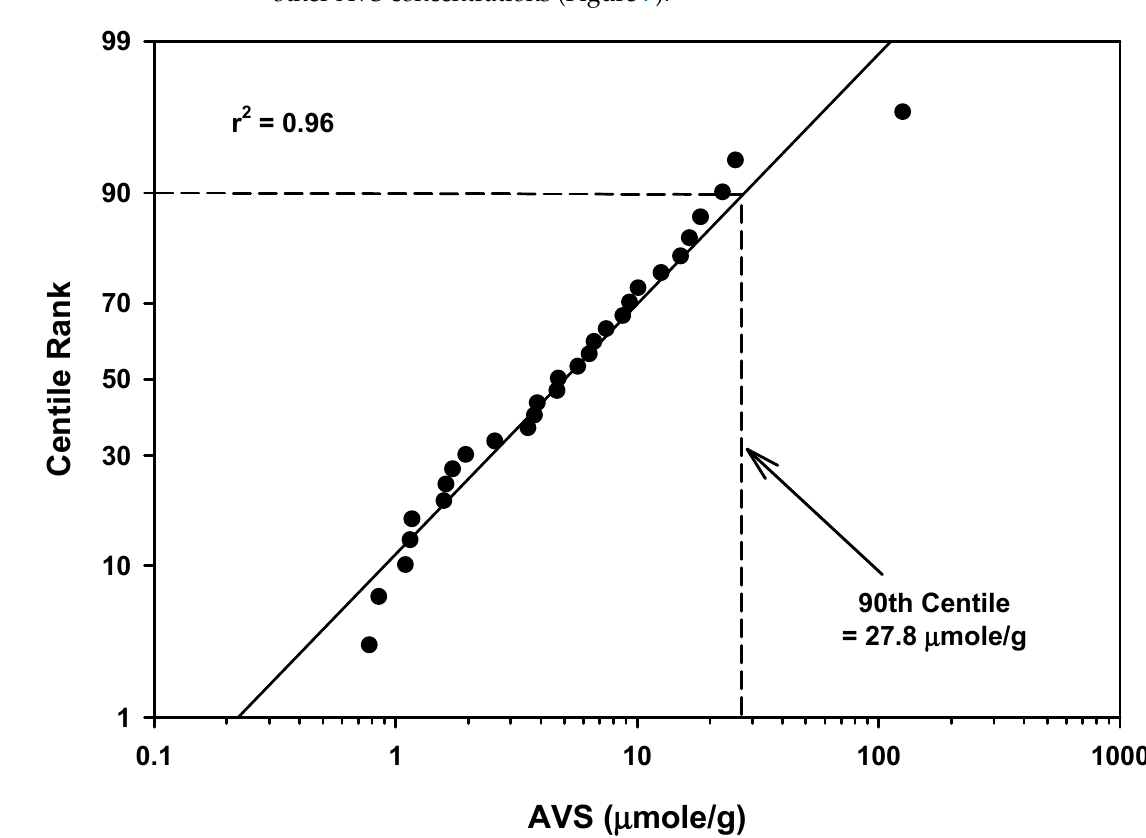
Figure 7. Regression of AVS field study means data for lakes/ponds/reservoirs against a probability scale showing the 90th centile rank.